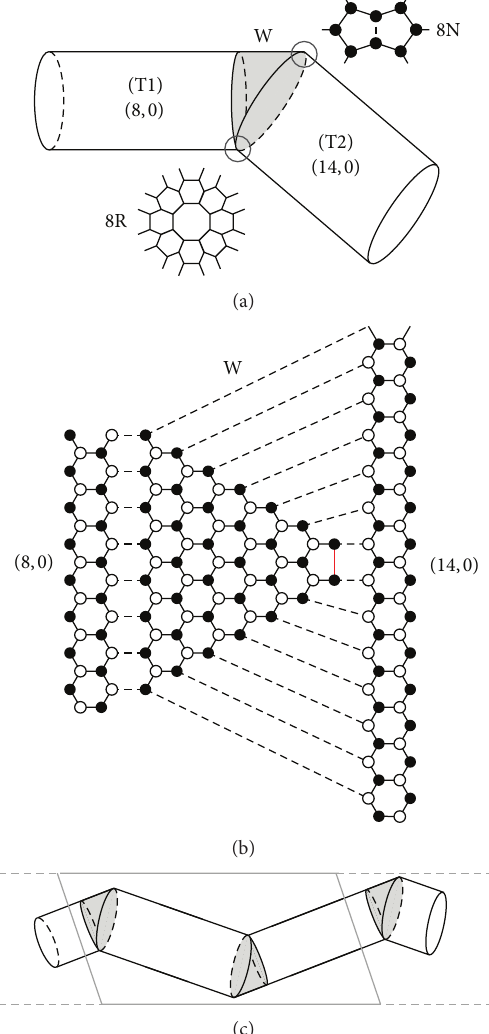
Figure 1: (a) Schematic diagonal junction between zigzag (8,0) and (14,0) nanotubes. The shaded region is the wedge (W) part between the two straight-cut tubes. The circles mark the positions of the octagonal defects 8R and 8N. Their atomic structure is also shown. (b) The junction showing all the edge atoms in the wedge and the unrolled unit cells of the (8,0) and (14,0) tubes. Filled and empty circles mark atoms of different sublattices. Dotted lines indicate the connections between the edge atoms of the nanotubes and the wedge. Short bold, red line in the right apex of the wedge marks the connection which reconstructs the 8N octagon into a pair of twopentagons.(c)Schematicunitcellofthe(8,0)/(14,0)superlattice, with the two complementary wedges